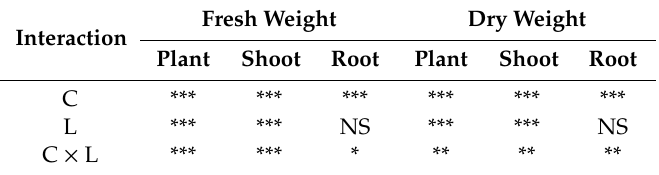
NS, *, **, *** represent non-significant or significant at p < 0.05, 0.01, and 0.001, respectively, according to two-way ANOVA, Tukey’s honest significant di ff erence tests. C = cultivars, L =